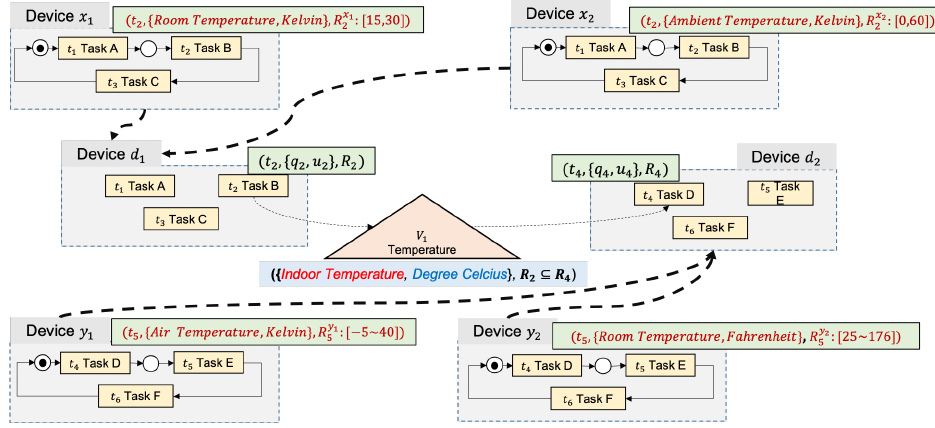
Figure 4. Example of a service design with logical devices and constraints.